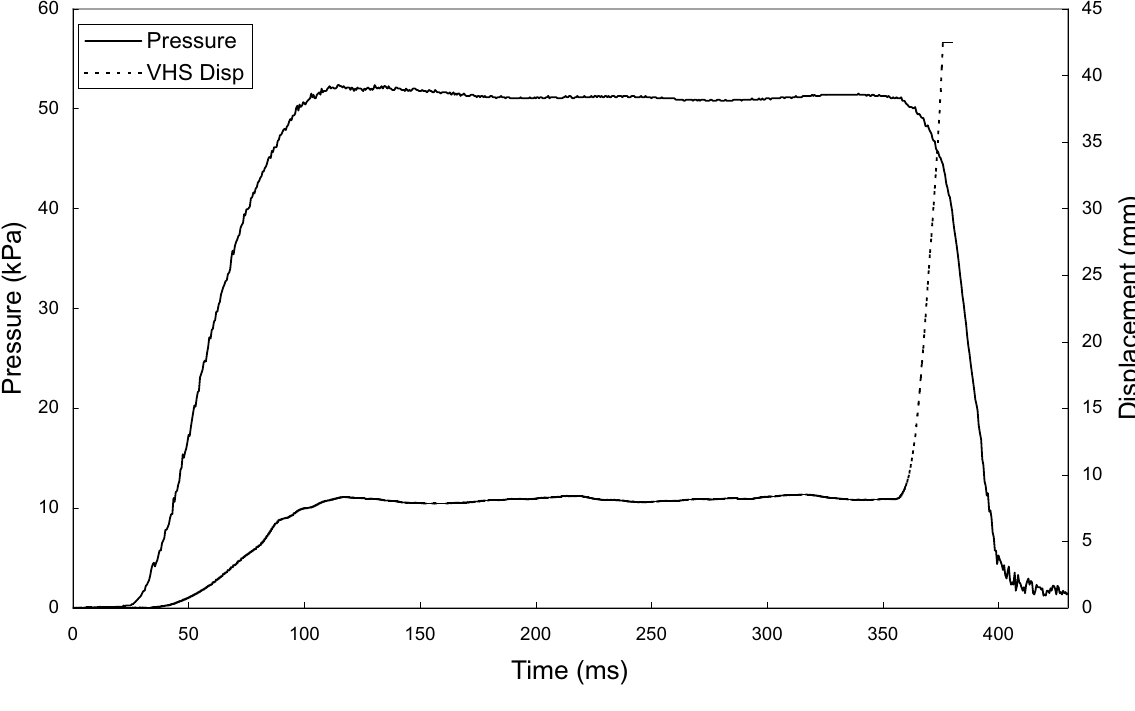
Fig. 10. Pressure and VHS laser displacement/ time histories for concrete paving